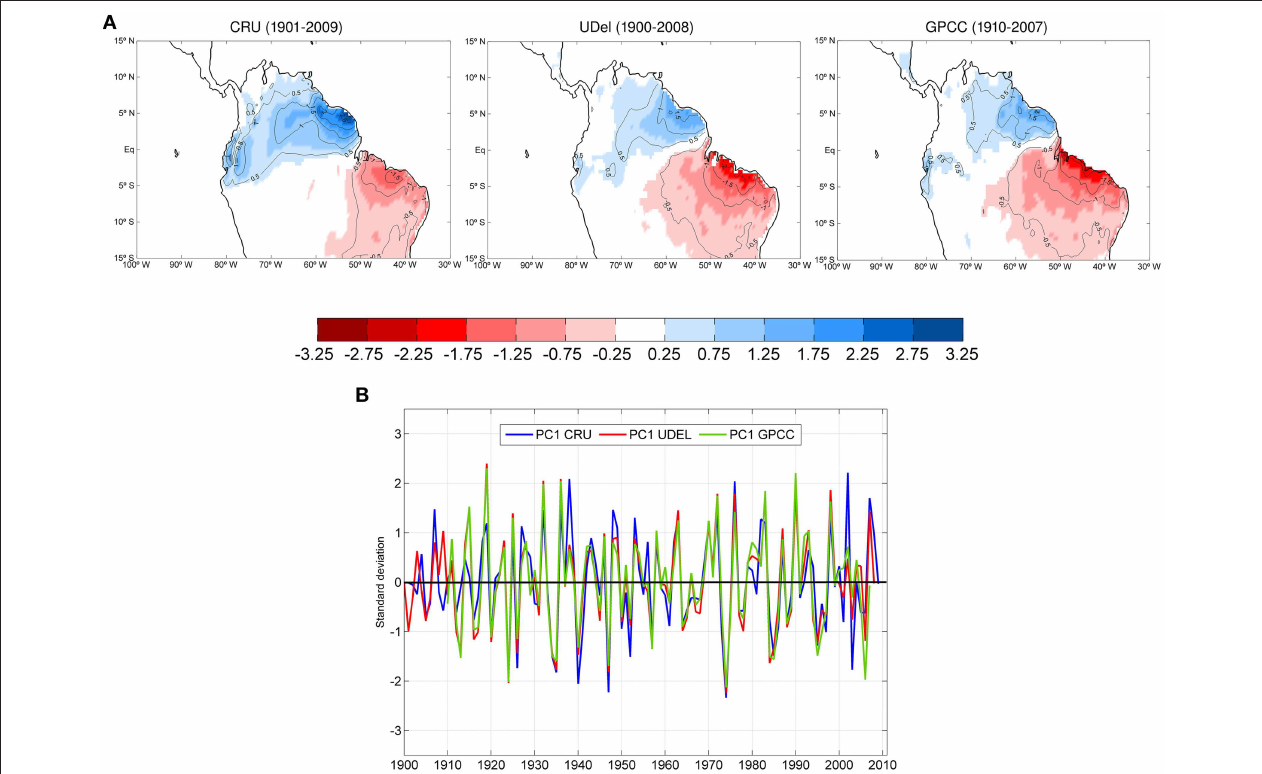
FIGURE 2 | (A) Leading empirical orthogonal function of the March-April-May (mm/day per std in the PC) anomalous rainfall. The regions with correlations significant at the 95% level are contoured. (B) Standardized principal component (PC1). They are associated with CRU (blue line), UDel (red line), and GPCC (green line) rainfall anomalies in